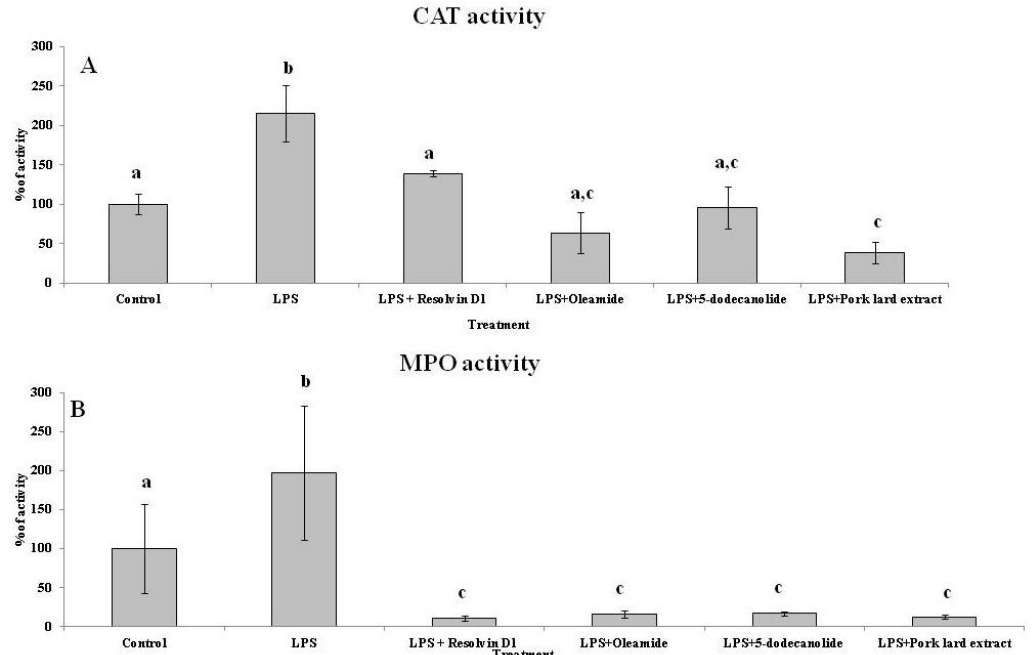
Figure 4. Antioxidant and anti-inflammatory effects of pork lard hydroalcoholic extract compounds neutrophils LPS-stimulated. CAT ( A ); MPO ( B ). Statistical analysis: One-way ANOVA test. Different letters indicate significant differences between the treatmnets ( p < 0.05).